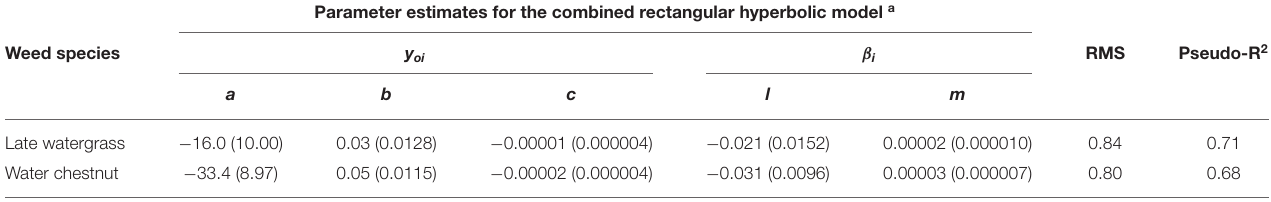
TABLE 4 | Parameter estimates for the combined rectangular hyperbolic model of rice grain yield as a result of single-weed interference caused by late watergrass and water chestnut at accumulated growing degree days (from transplanting to flowering, 89 days) in the pooled 3-year data. Parameter estimates for the combined rectangular hyperbolic model a